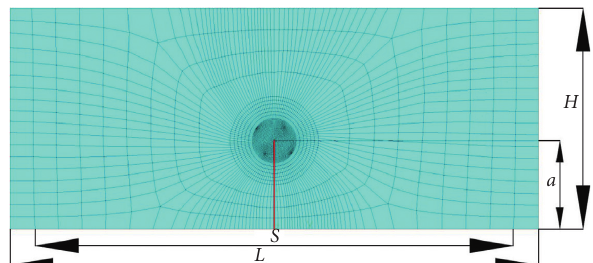
Figure 1: Model of three-point bending tests on notched beams in Abaqus ( L , length; H , depth; S , span; a , notch length), where the span- depth ratio ( S / H ) is 2.17.